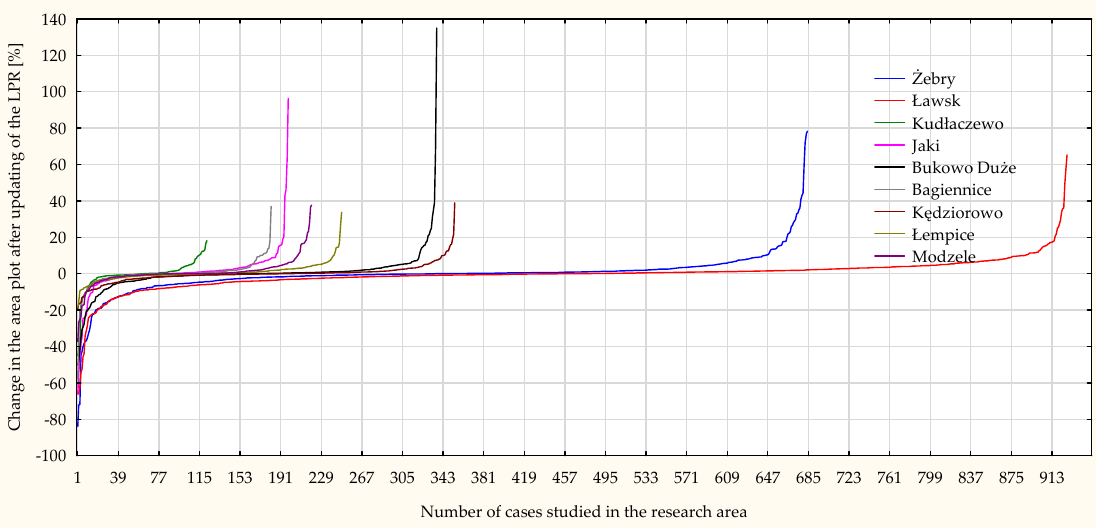
Figure 3. Distribution of the plot area change index [%] in the villages under study. Source: own study on Statistica 13.1.